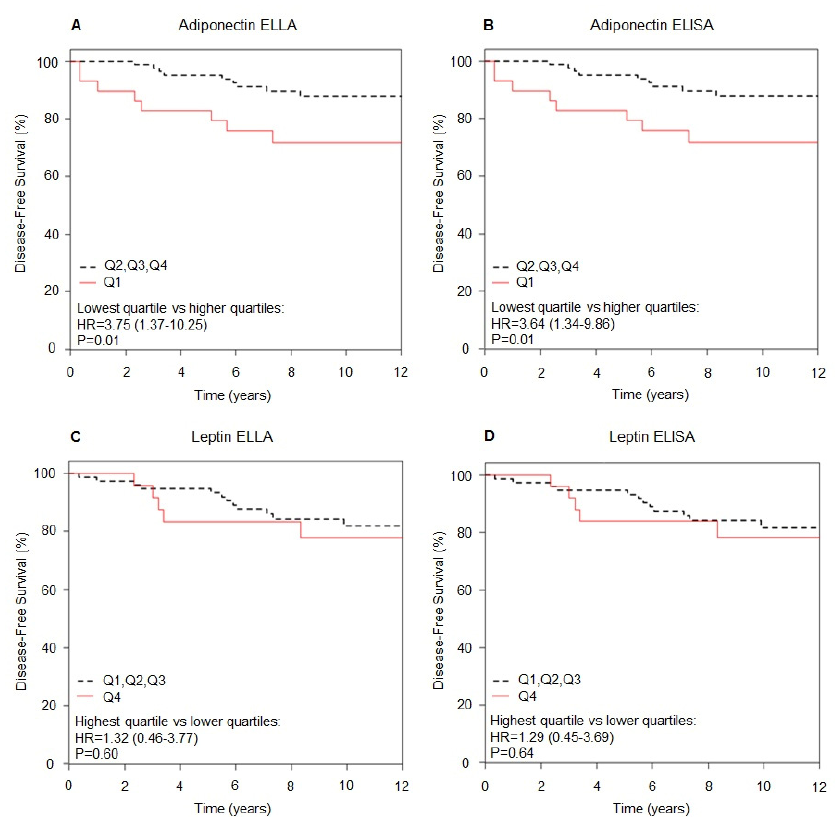
Figure 4. Disease-free survival curves according to lowest quartile versus higher for adiponectin ( n = 116) measured with ELLA ( A ) or ELISA ( B ) and highest quartile versus lower for leptin ( n = 104) measured with ELLA ( C ) or ELISA ( D ). Disease-free survival was calculated including subjects with resected DCIS and high risk healthy subjects.